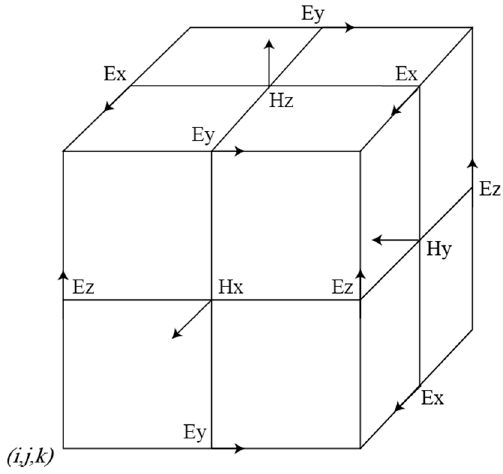
Figure 3. Schematic diagram of electric and magnetic field components of Yee cell in FDTD.